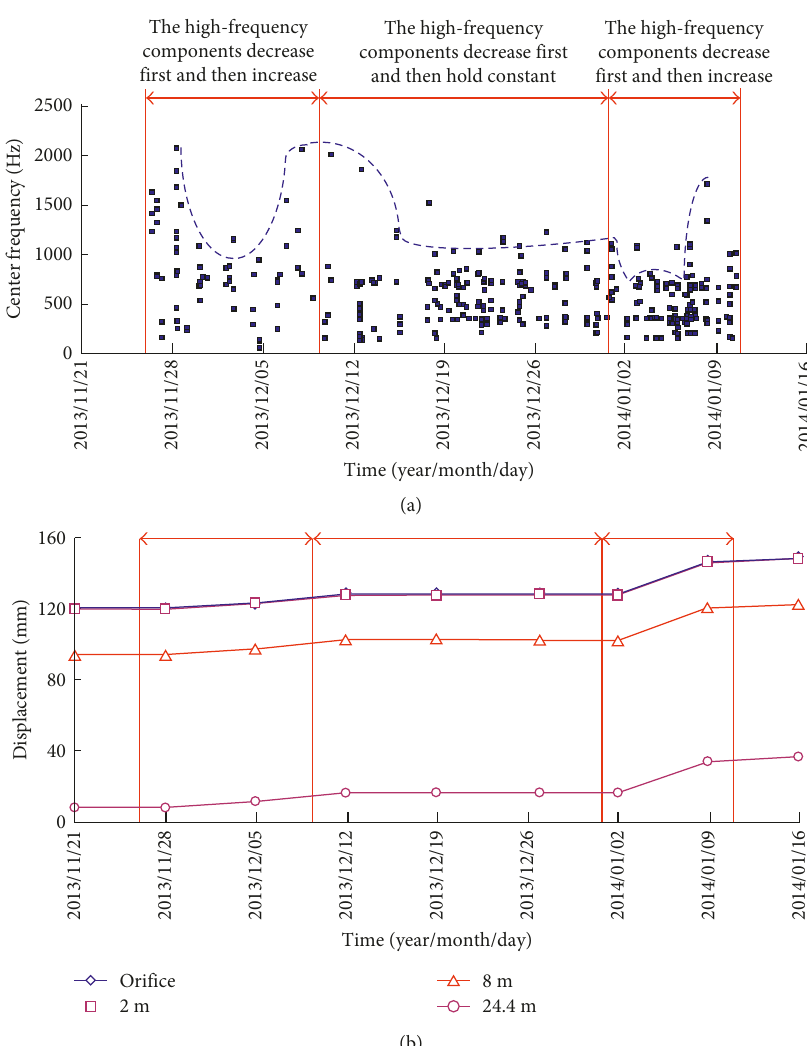
Figure 7: Temporal distribution regularities of the center frequency of MS events (a) and the displacement process curve of multipoint extensometers M 4 CF 3-8